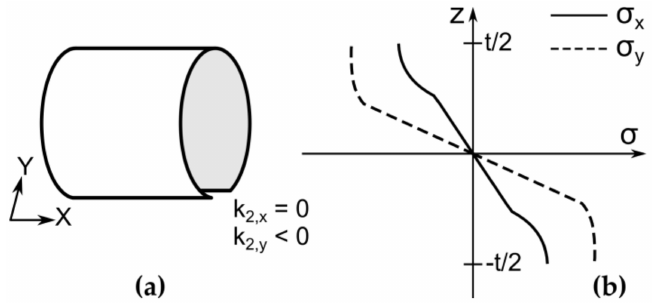
Figure 8. Shell geometry ( a ) and stress distribution along the shell thickness ( b ) after second bending.